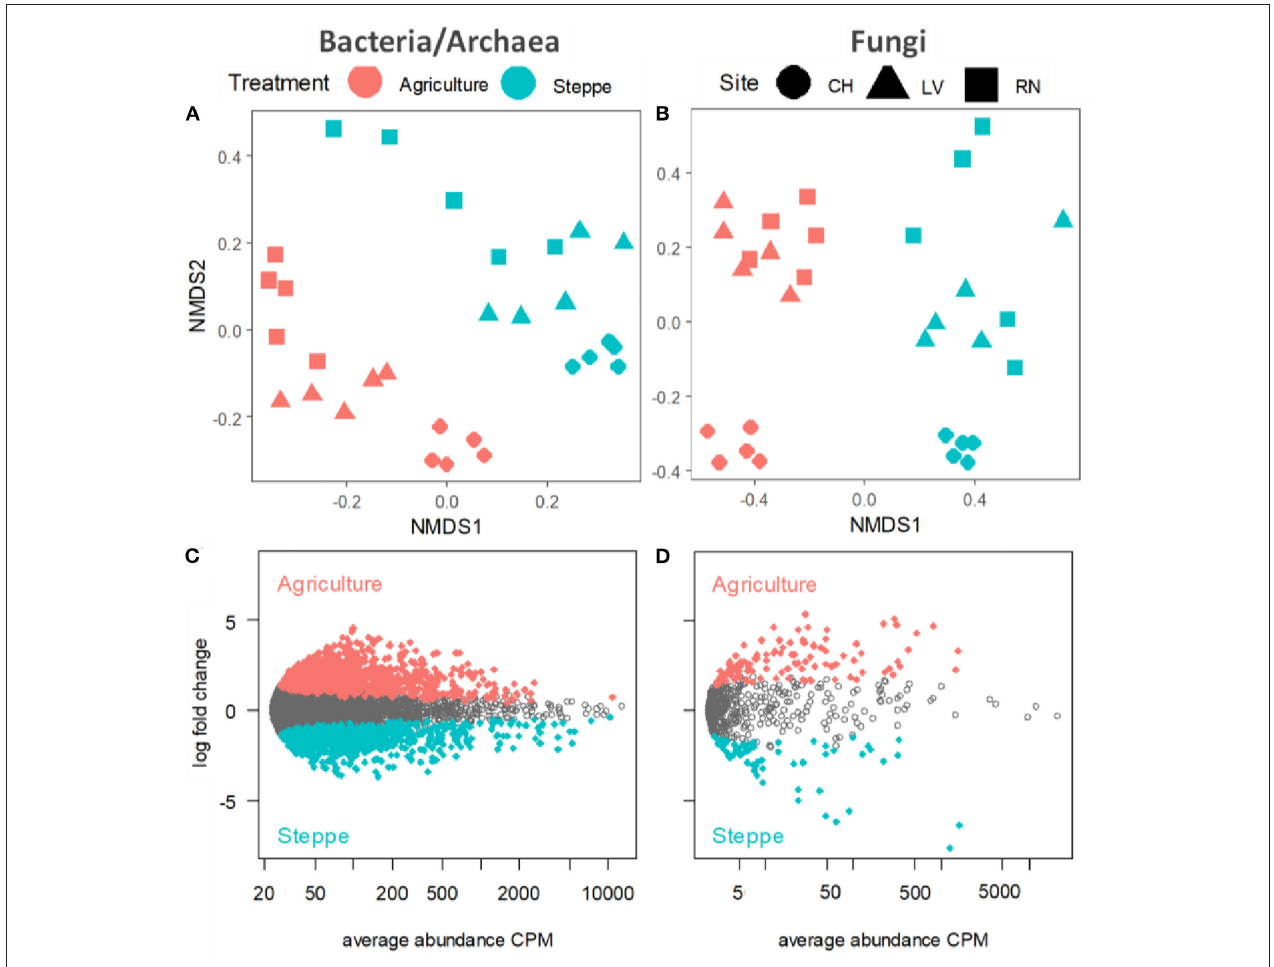
FIGURE 5 | Non-metric multi-dimensional scaling (NMDS) plots of community composition in irrigated agriculture and steppe plots in each site for (A) bacteria/archaea and (B) fungi. Plots display the abundance patterns of (C) bacteria and (D) fungi in irrigated agriculture and steppe soil. X-axis reports average OTU abundance (as counts per million, CPM), and Y-axis log2-fold change. Agriculture and steppe-specific OTUs were colored in redish and greenish, respectively, and non-differentially abundant OTUs are in gray (likelihood ratio test, p < 0.05, FDR